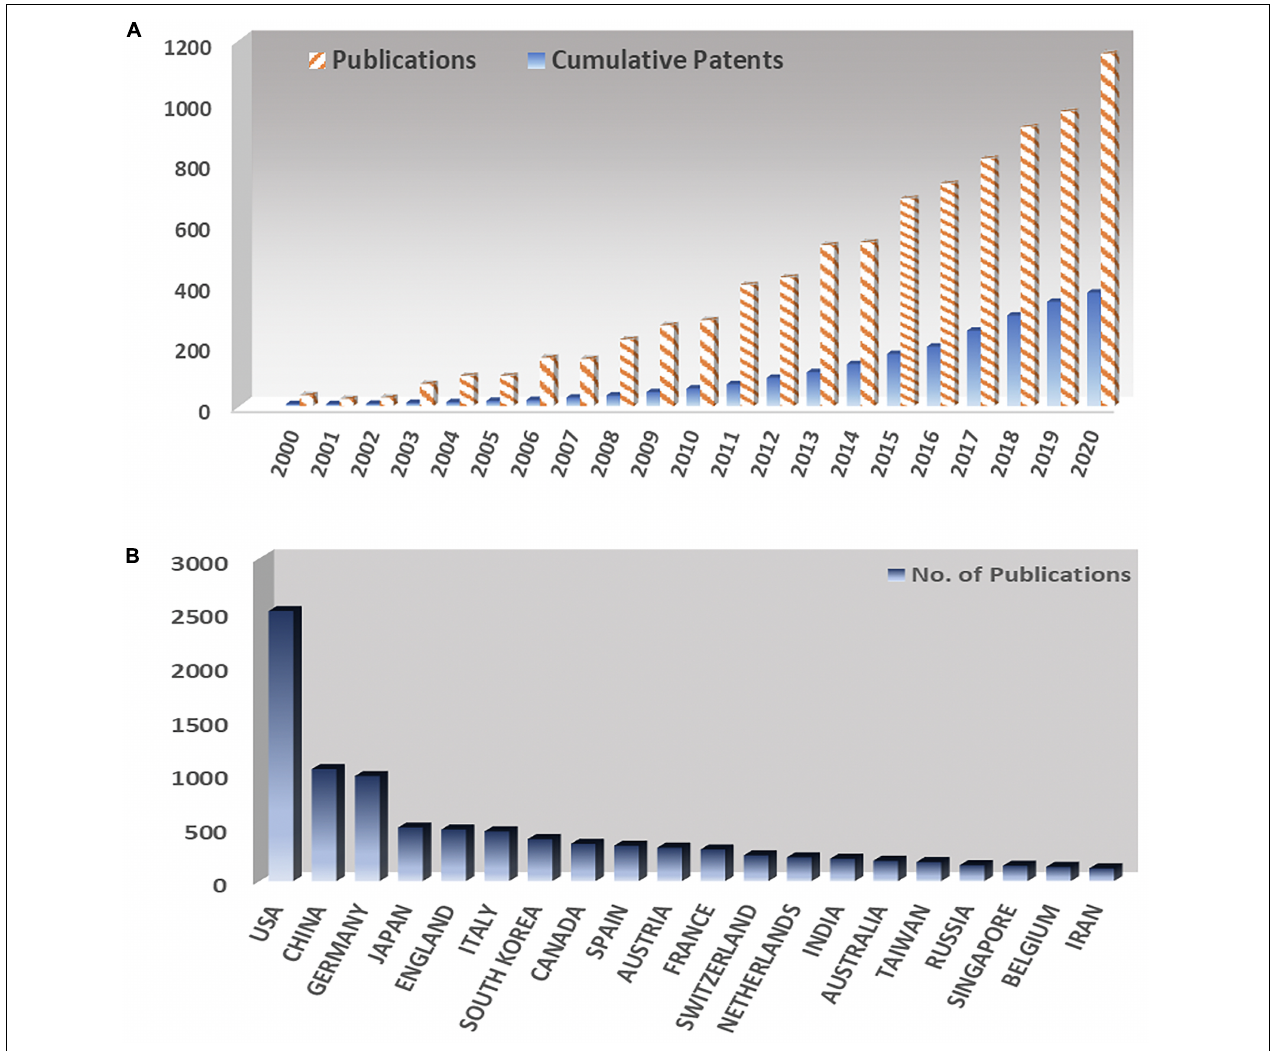
FIGURE 2 | (A) Yearly number of publications and number of patents in the field of brain machine interfaces since 2000. (B) Number of publications on brain machine interfaces at different countries.